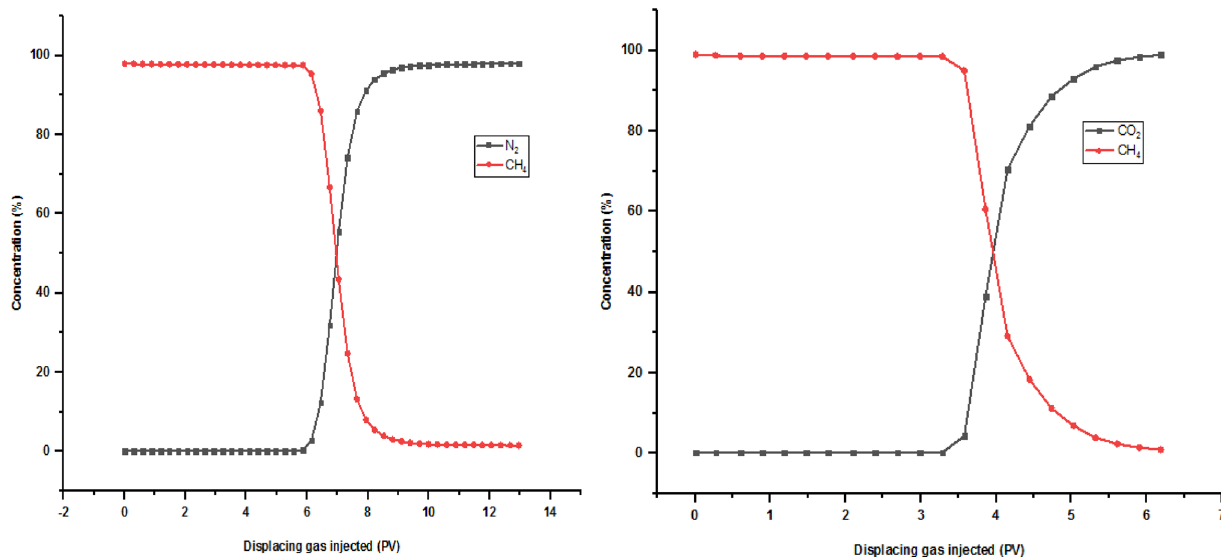
Fig. 10 Conventional N 2 and CO 2 injection effluent concentration